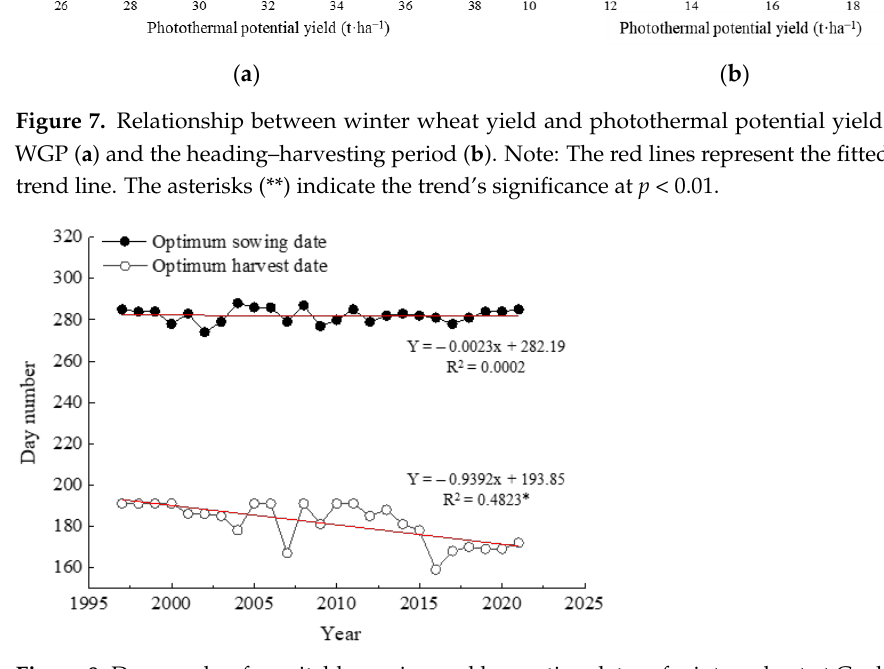
Figure 8. Day number for suitable sowing and harvesting dates of winter wheat at Gucheng station during 1997–2021. Note: The black solid dot (black hollow circle) is the day number of the optimum sowing date (optimum harvest date) in different years. The red lines represent the fitted regression trend line. The asterisks (*) indicate the trend’s significance at p < 0.05.